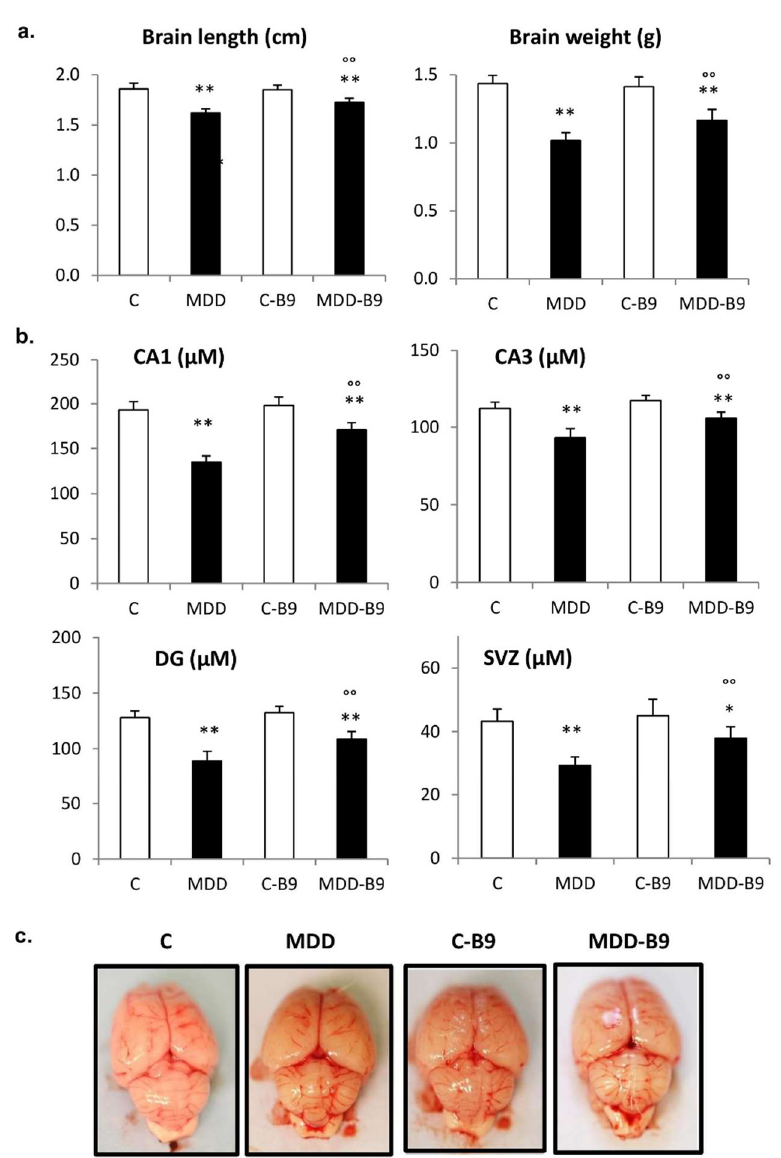
Figure 4. Brain defects associated with maternal methyl donor deficiency in rat pups: influence of folic acid supplementation. ( a ) Brain length and weight in control (C), methyl donor deficient (MDD), supplemented control (C-B9) and supplemented deficient (MDD-B9) rat pups at 21 days (20 ≤ n ≤ 40). Statistically significant differences between control and MDD rats: ** p < 0.01, between MDD and supplemented MDD: ◦◦ p < 0.01; ( b ) thicknesses of hippocampal CA1 pyramidal cell layer, CA3 pyramidal cell layer, granular cell layer of the dentate gyrus (DG), and subventricular zone (SVZ) at 21 days (6 ≤ n ≤ 10). Statistically significant differences between control and MDD rats: * p < 0.05 and ** p < 0.01, between MDD and supplemented MDD: ◦◦ p < 0.01; ( c ) Photographs of representative brain samples showing the absence of macroscopic defects (e.g., improper interhemispheric junction and cerebellar vermis closure) at 21 days regardless of the experimental group.